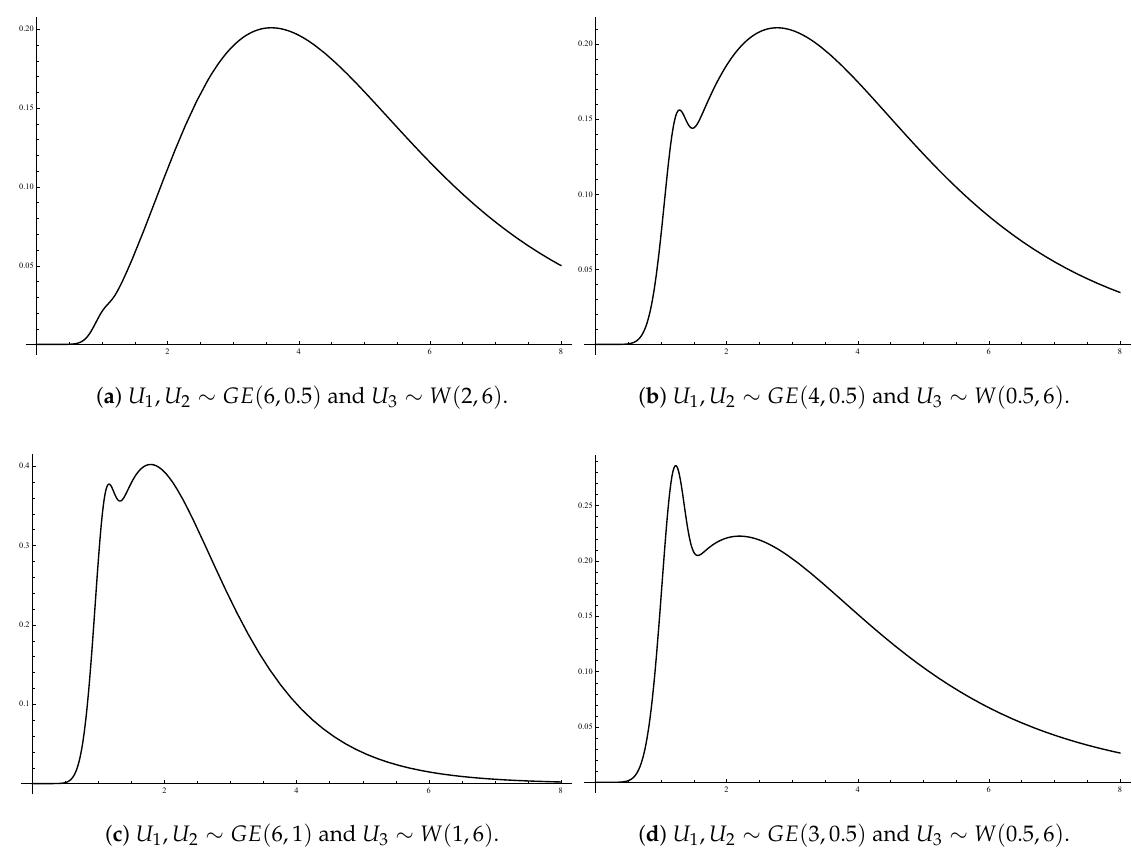
Figure 2. Plots of the marginal pdfs of the GBD models ( X 1 , X 2 ) with different components ( U 1 , U 2 , U 3 )